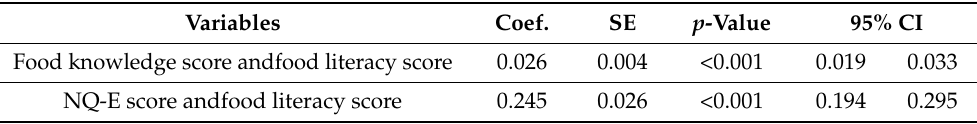
Table 5. Linear regression analysis. Variables Coef. SE p -Value 95% CI Food knowledge score andfood literacy score 0.026 0.004 <0.001 NQ-E score andfood literacy